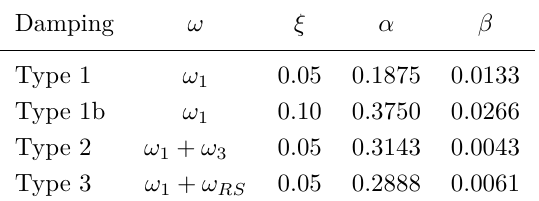
Table 3. Rayleigh damping parameters.